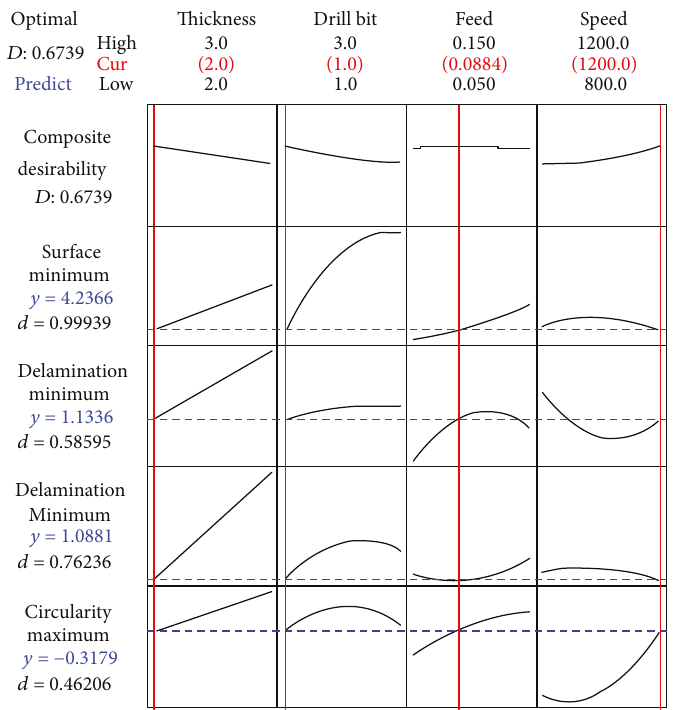
Figure 11: Optimization